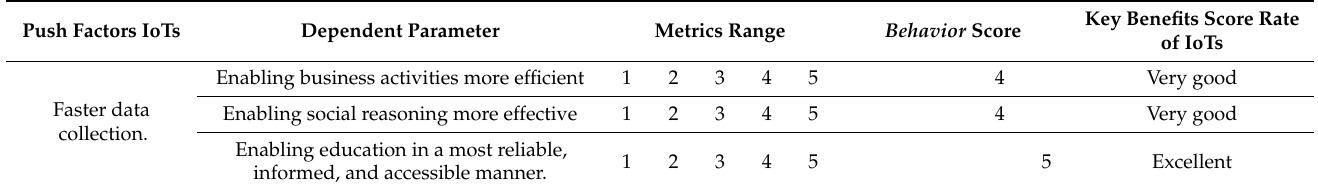
Table 3. The determination of Behavior scores of the Influence of IoTs based on faster data collection.